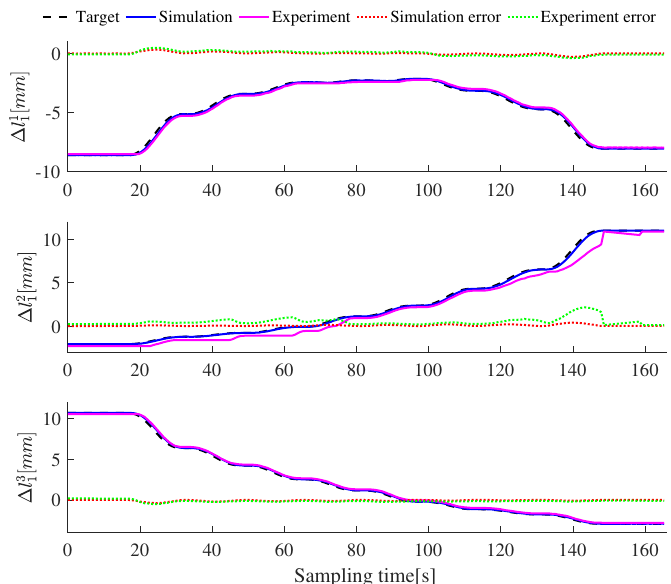
Figure 15. Length change of ∆ l 1